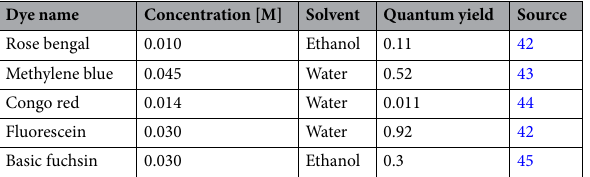
Table 1. Properties of the dye samples used for validating the TA-PARS